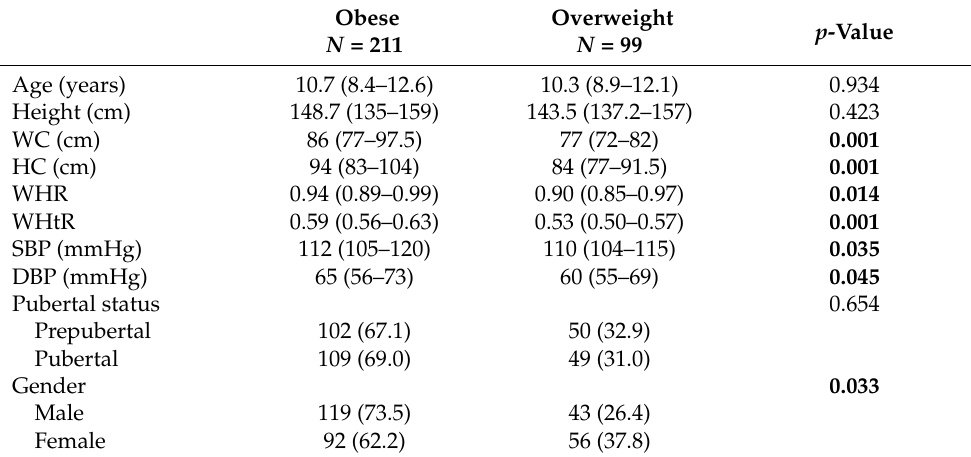
Table 1. Clinical characteristics of all subjects at